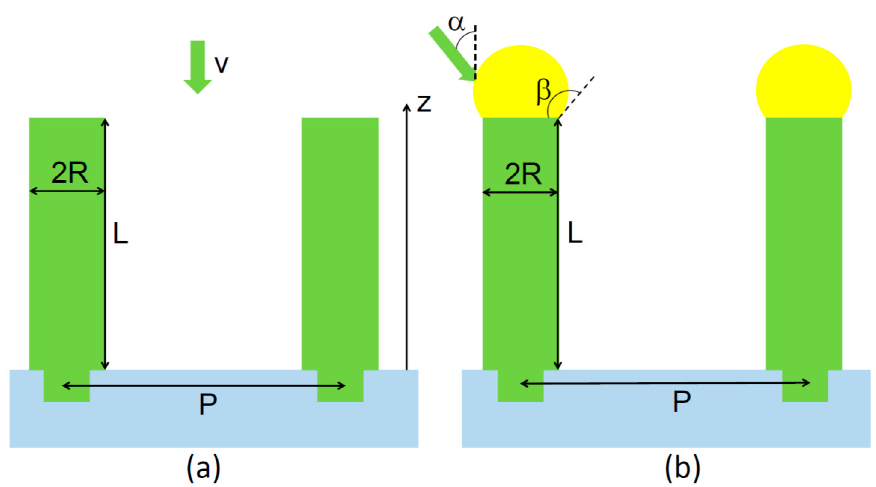
Figure 1. Illustration of the model geometry in ( a ) SAG and ( b ) VLS growth with a metallic droplet on top.